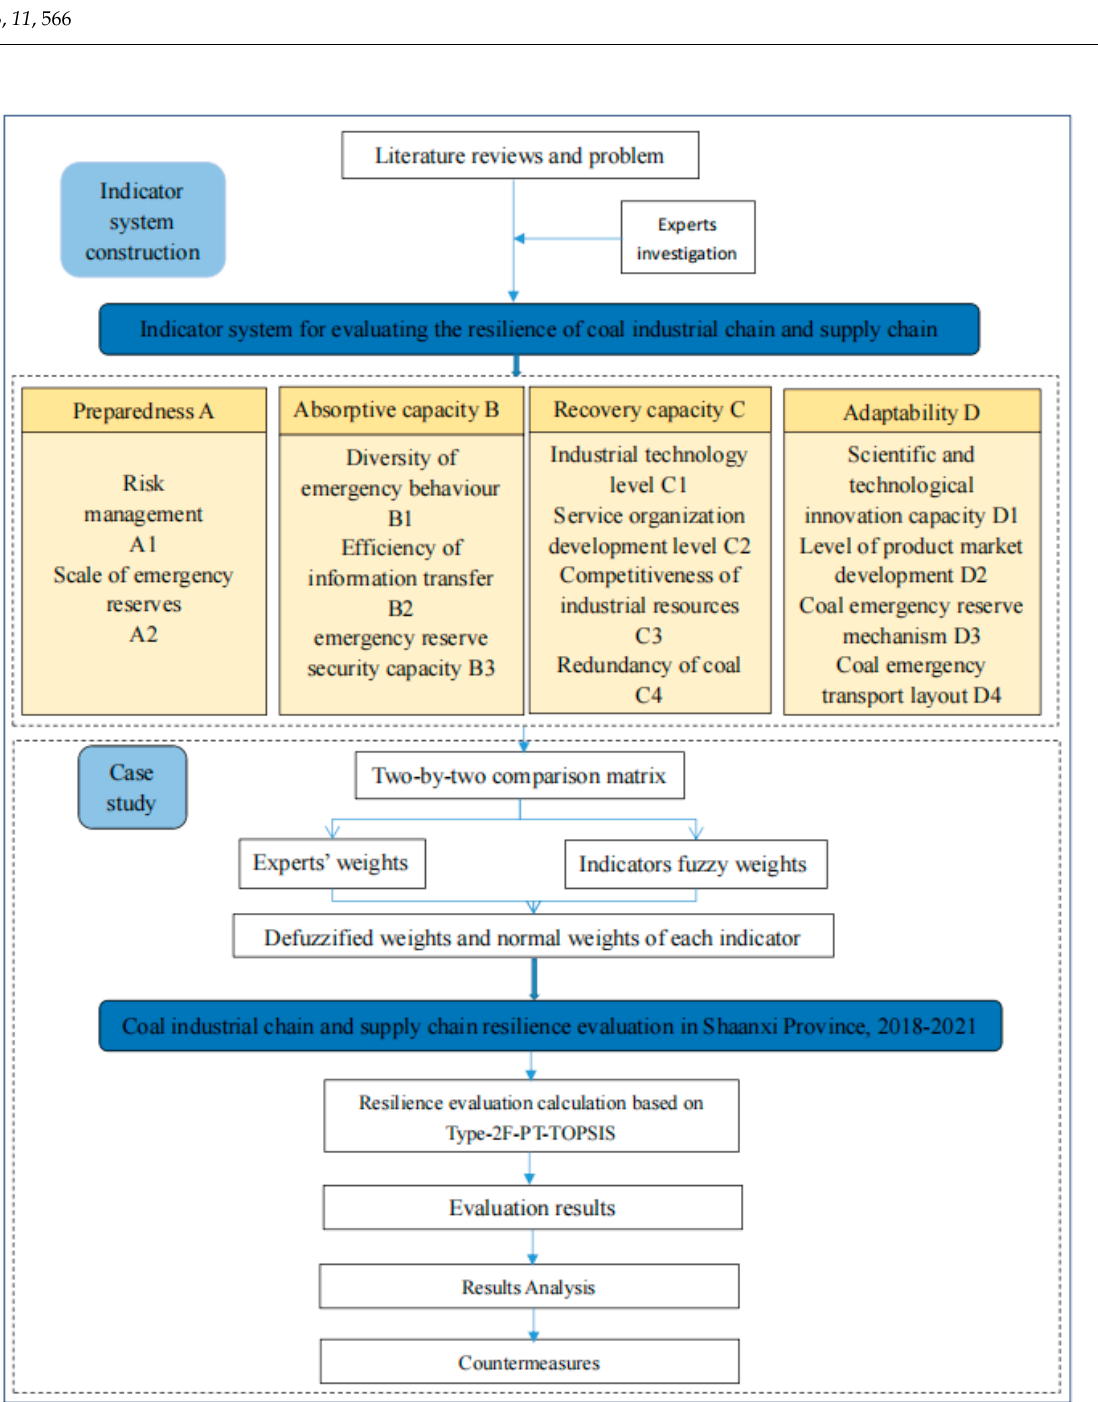
Figure 3. Technical roadmap for coal industrial chain and supply chain resilience